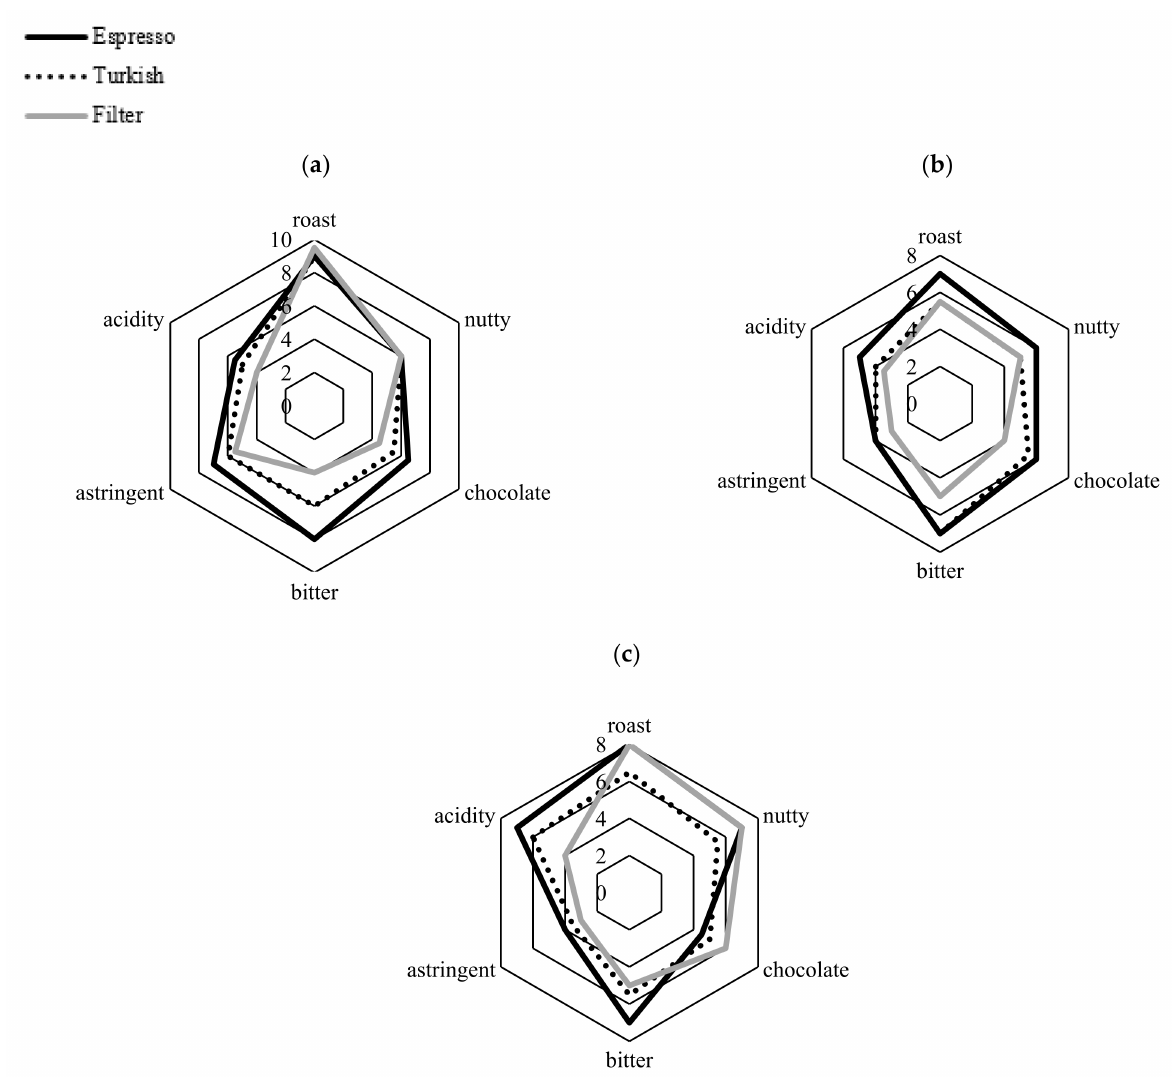
Figure 5. Results of the sensory evaluation of final coffee blends: ( a ) CF_1; ( b ) CF_2; ( c ) CF_3. Supplementary Materials: The following are available online, Table S1: The results of the statistical analysis of the sensory evaluation of espresso coffee brews made from roasted coffee beans, Table S2: The results of the statistical analysis of the sensory evaluation of Turkish coffee brews made from roasted coffee beans, Table S3: The results of the statistical analysis of the sensory evaluation of filter coffee brews made from roasted coffee beans, Table S4: The results of the statistical analysis of the sensory evaluation of espresso brews made from final coffee blends, Table S5: The results of the statistical analysis of the sensory evaluation of Turkish brews made from final coffee blends, Table S6: The results of the statistical analysis of the sensory evaluation of filter brews made from final coffee